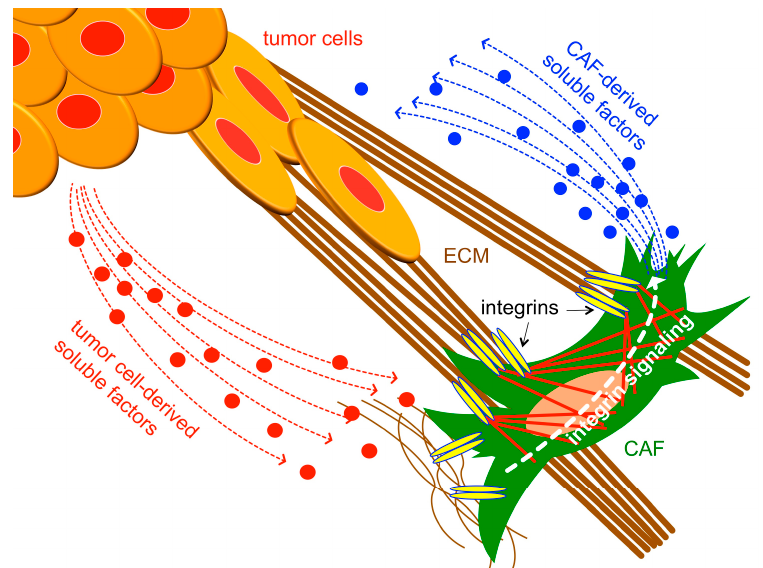
Figure 2. Integrins expressed on CAFs may control their ability to modulate the TME through both chemical signals and mechanical signals propagated through changes in ECM stiffness, as well as their ability to respond to chemical and mechanical cues from the TME.